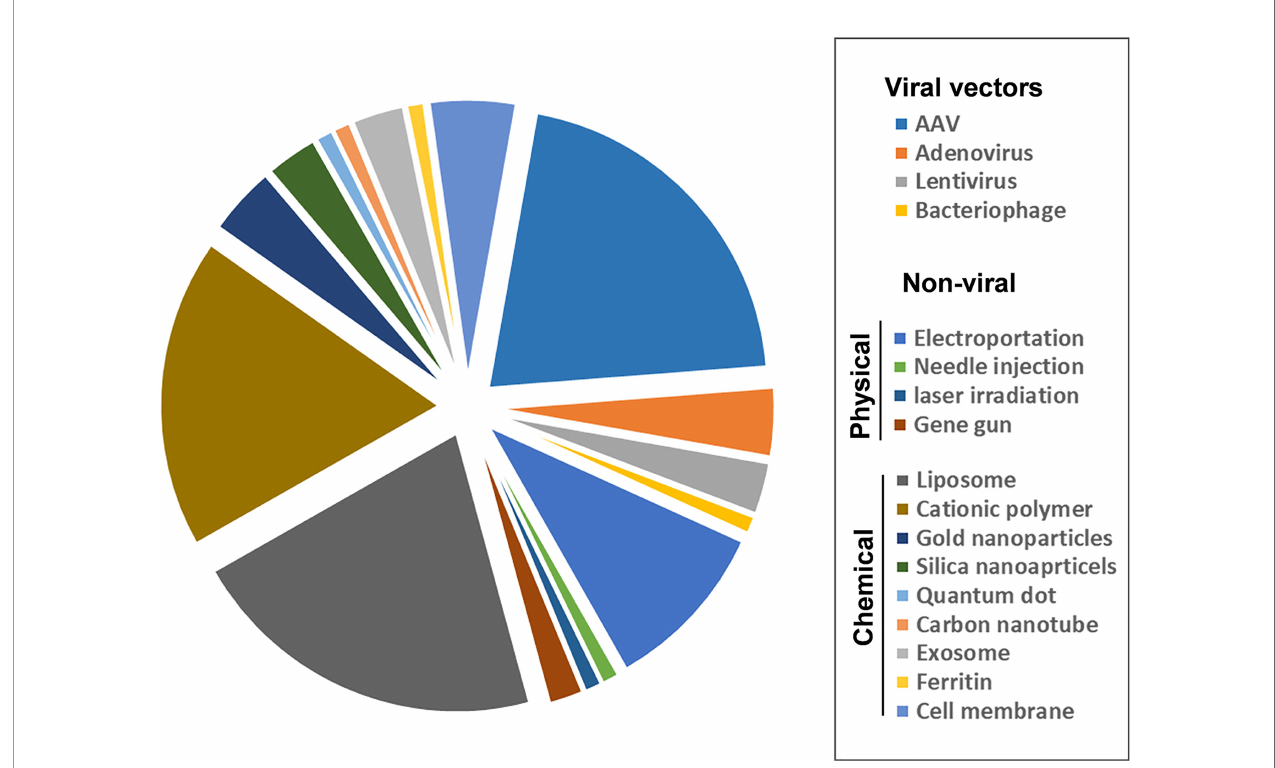
FIGURE 3 | Representation of viral and non-viral nano-delivery systems classi fi ed as viral vectors, non-viral (physical and chemical). AAV, adeno-associated virus. The total number of papers is 18,968 obtained from PubMed, and Microsoft Excel was used to obtain the pie graph. The keywords are the name of vectors and gene delivery or CAR